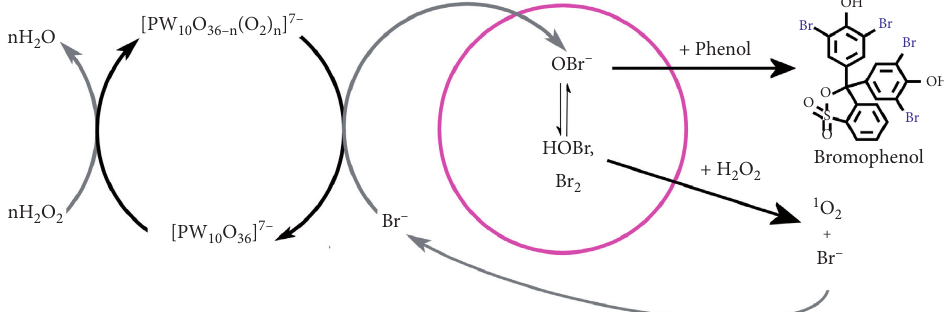
Figure 25: The proposed full reaction mechanism of the limiting reagent NH